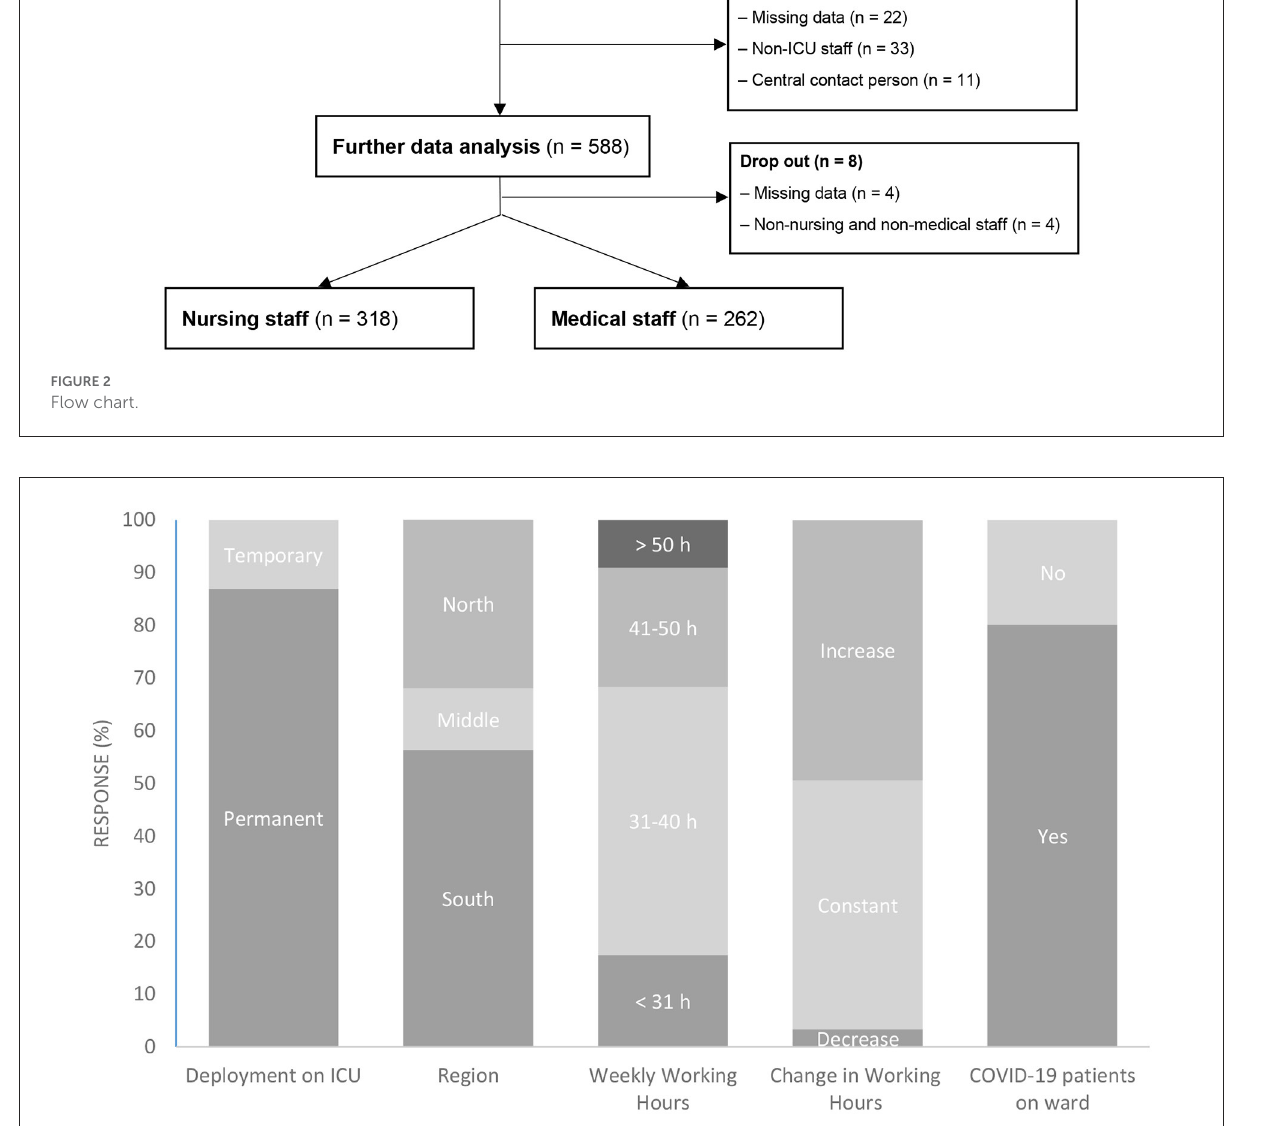
FIGURE3 Participant demographics. ICU, Intensive Care Unit; h, hours. Participants were characterized according to the duration of their ICU deployment during the first wave of the COVID-19 pandemic (column 1), the region in Germany where they worked (column 2), their weekly working